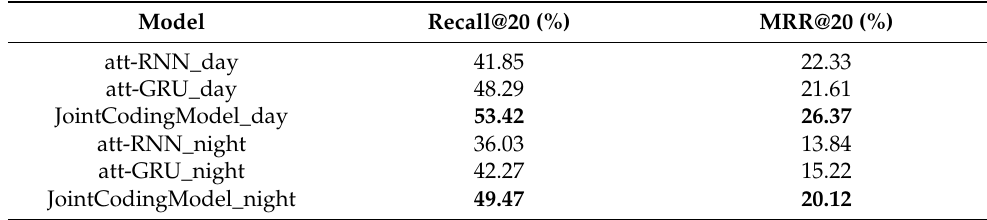
Table 3. Experimental results of day–night group.